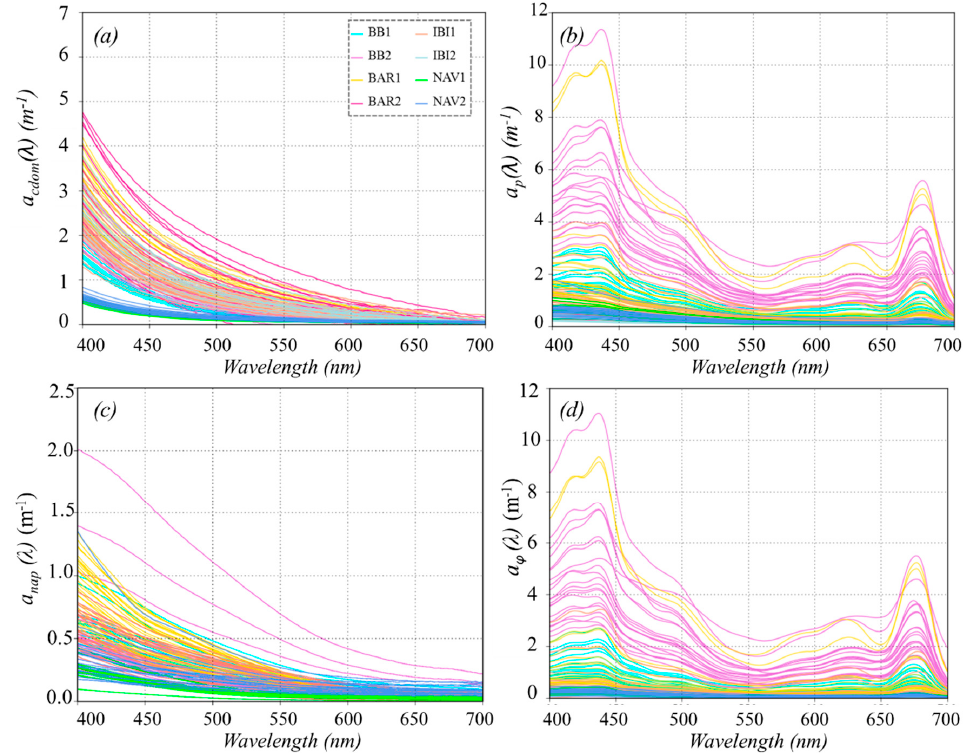
Figure 3. In situ absorption spectra from all of the sampling locations for (a) a cdom ; (b) a p ; (c) a nap ; and (d) a φ .